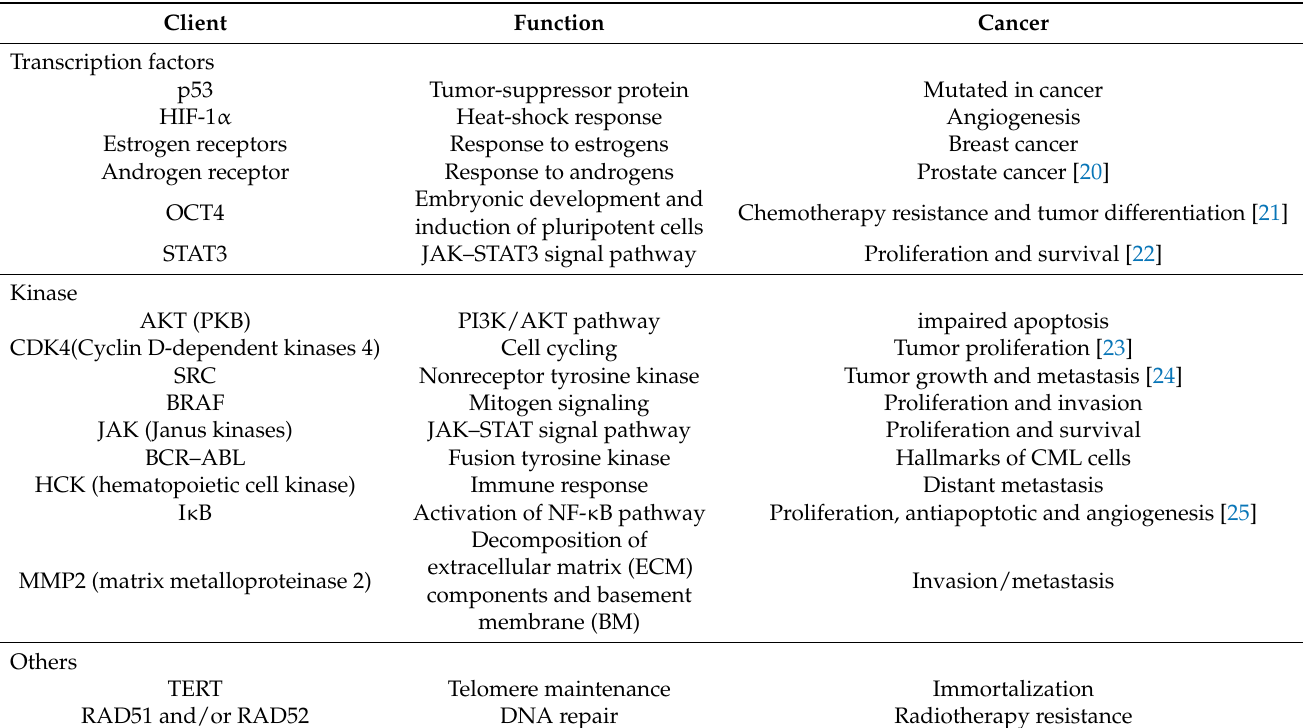
Table 1. HSP90’s oncogenic